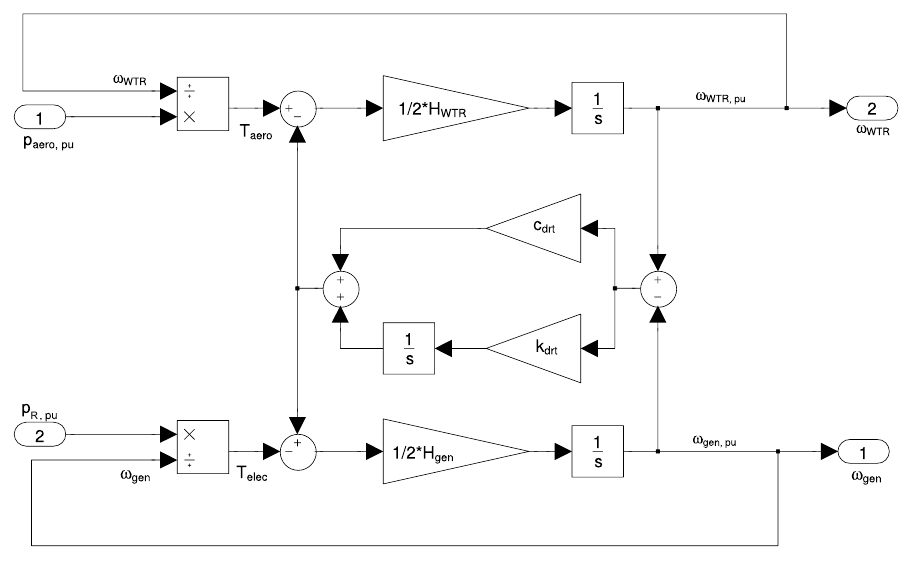
Figure 5. Two-mass mechanical